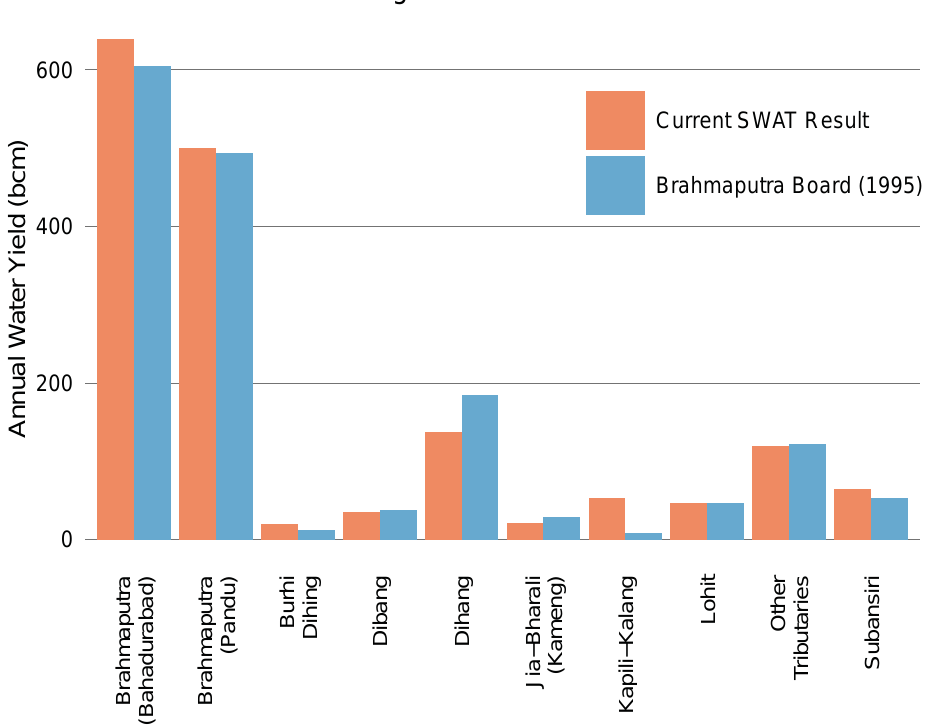
Figure 7. Average annual water yield (AWY) in the major tributaries of the Brahmaputra River Basin is estimated by the SWAT model and reported by the Brahmaputra Board